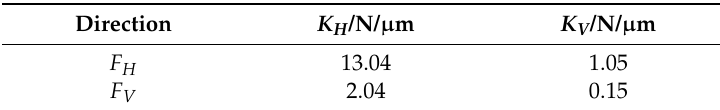
Table 4. Stiffness in the horizontal and vertical directions.